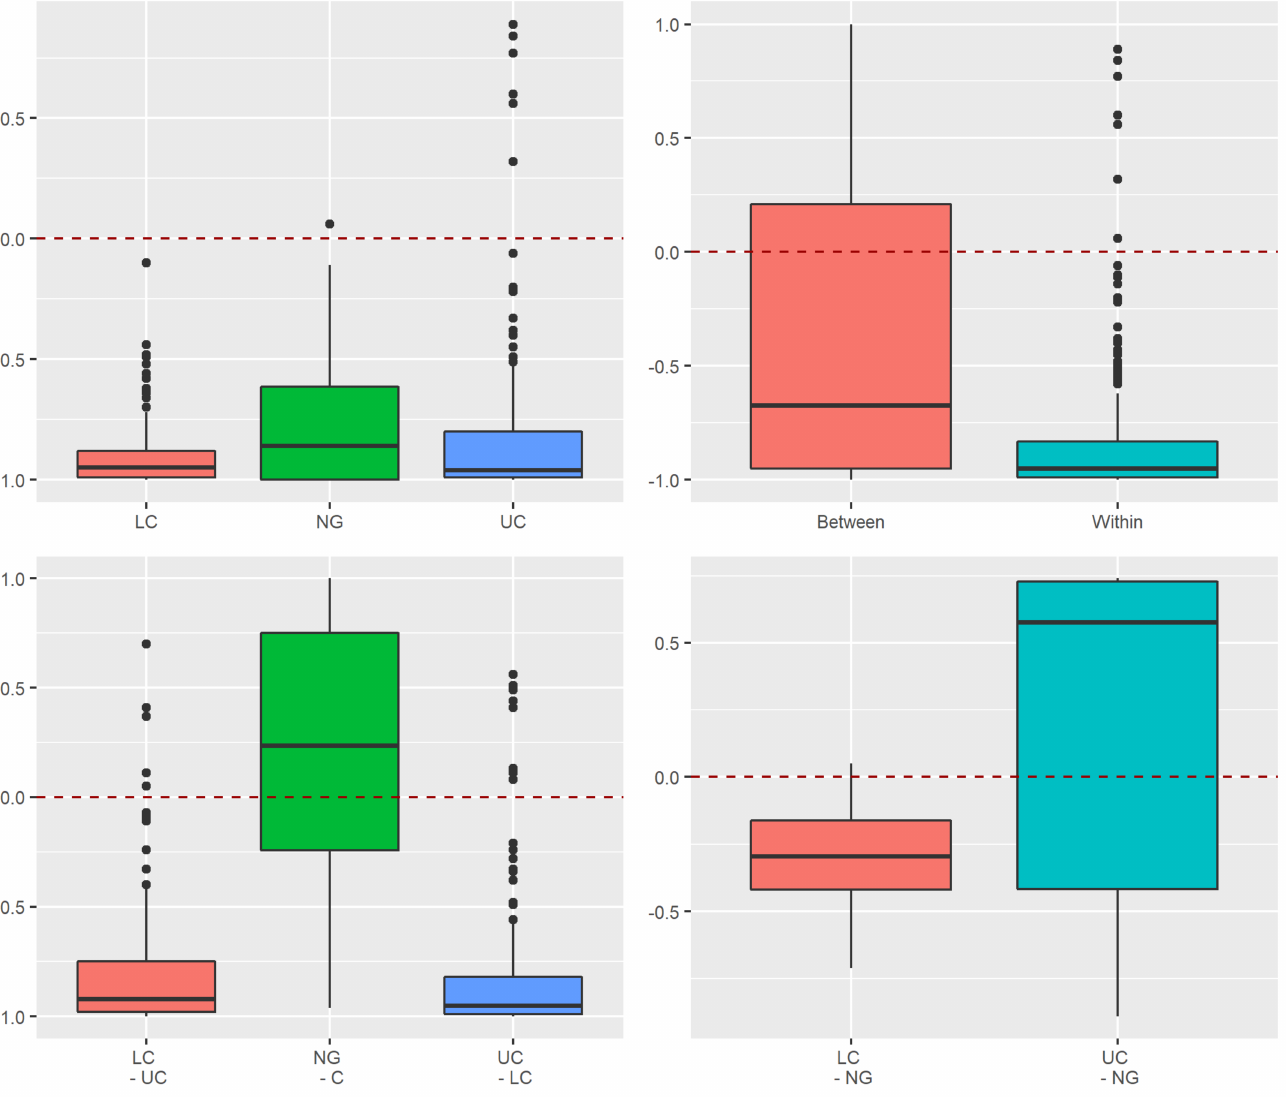
Figure A2. Deviation of the beta diversity from the diversity expected by the null hypothesis per stratum for the common beetle species. NG—near-ground stratum, LC—lower canopy, UC— upper canopy. Comparisons within a stratum are comparisons of two traps of the same stratum. Comparisons between strata are comparisons of two traps from two different